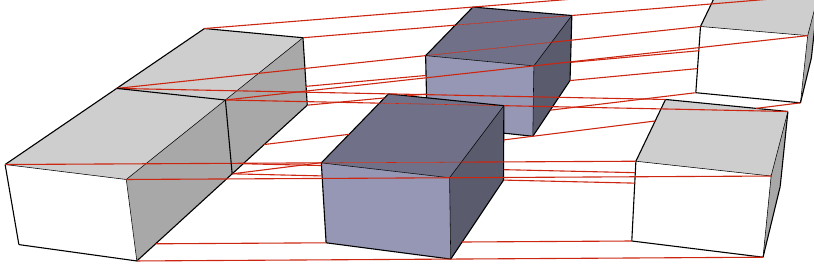
Figure 4. Two LODs of two houses being aggregated are integrated into a 4D model by modifying the topology of the model at the lowest LOD so as to match the topology of the model at the highest LOD.